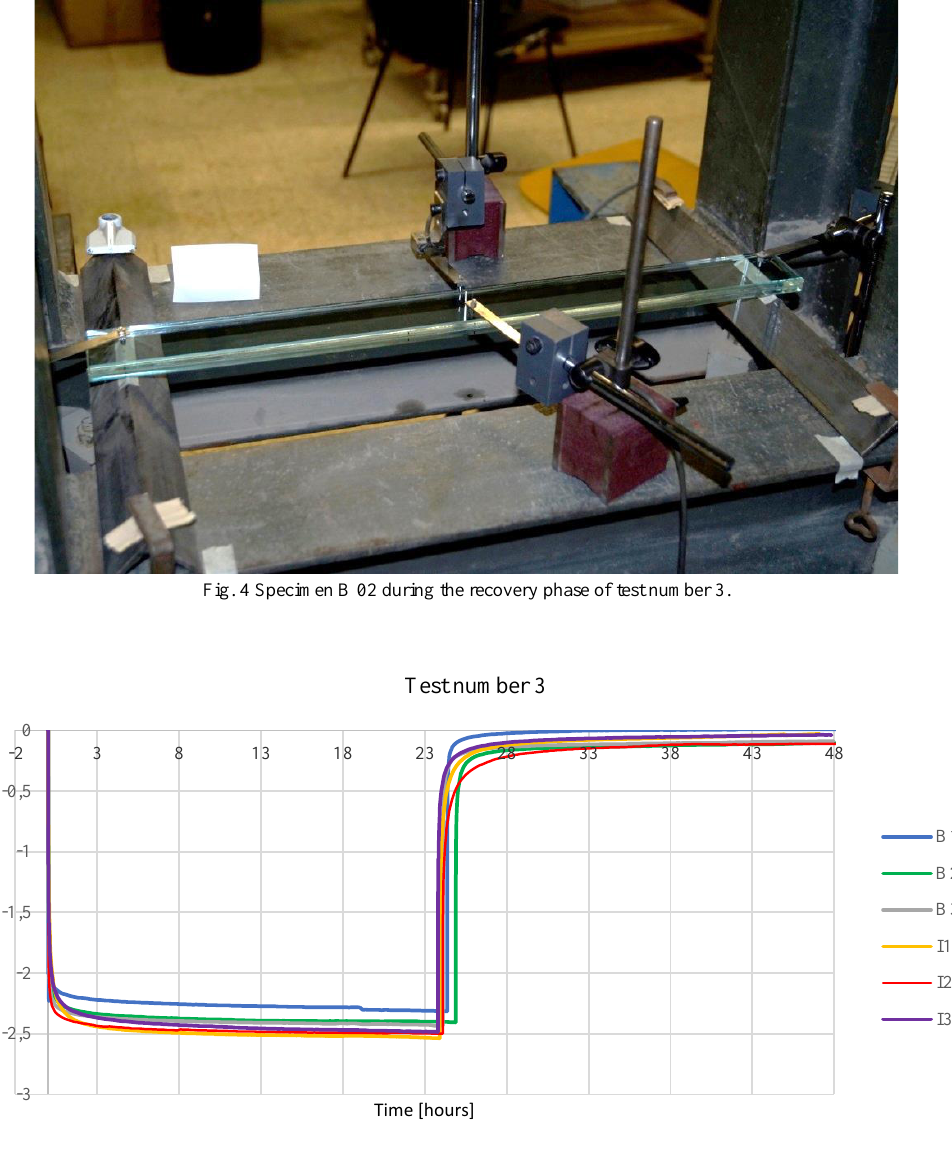
Fig. 5 Deflection versus time diagram for the six specimens tested; test number 3.